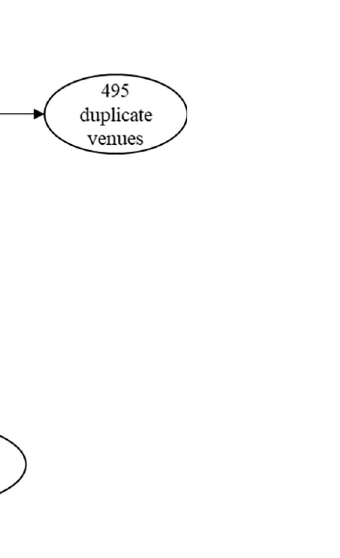
Fig 1. Flowchart of venue mapping activities in (A) Addis Ababa and (B) Gambella.